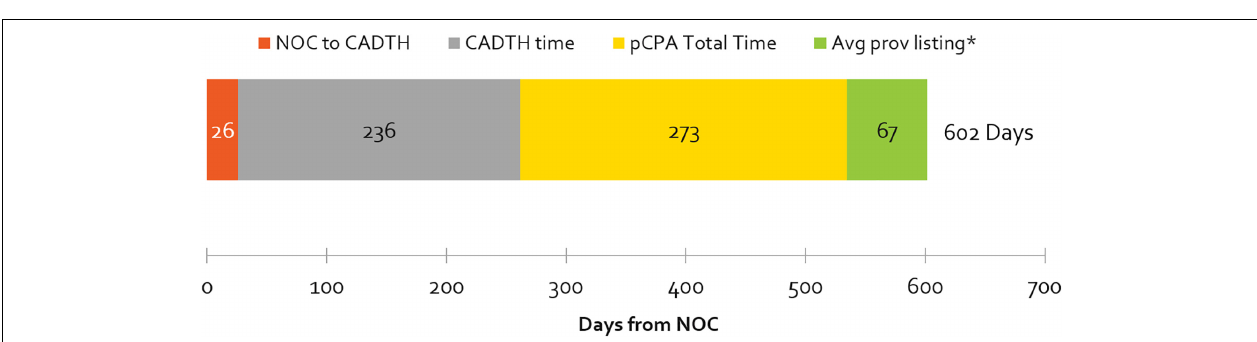
FIGURE 3 | Average number of cumulative and segmental days from NOC to at least one provincial listing, by review agency, 2012–2016 ( ∗ excludes products with artificial pCPA dates of completed negotiations published January 31, 2014). Average times to listing in Quebec are excluded. Note that the pCPA total time includes time from when the CADTH recommendation is issued, to the start of a pCPA negotiation. pCPA times could be ± 30 days, as negotiation start and end times are published as the last day of every